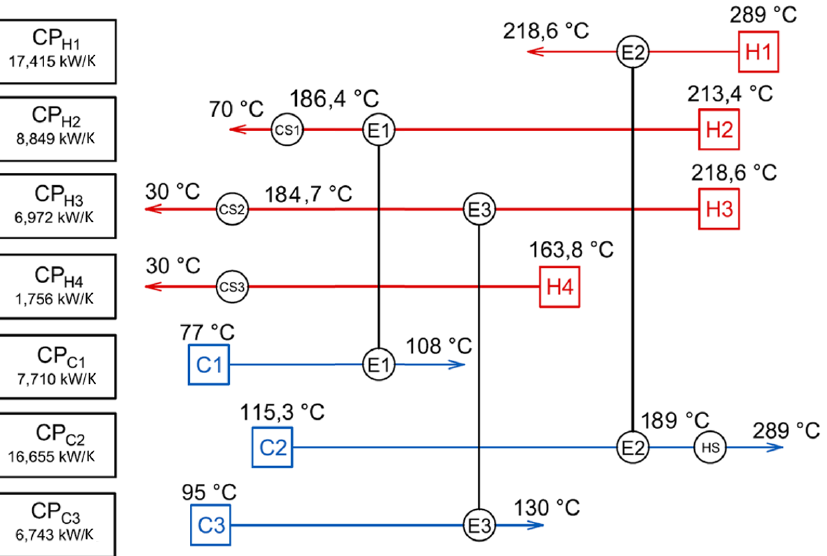
Figure 5. Grid Diagram of the existing HEN. Table 1. The geometric and process characteristics of HEs employed in the current HEN.